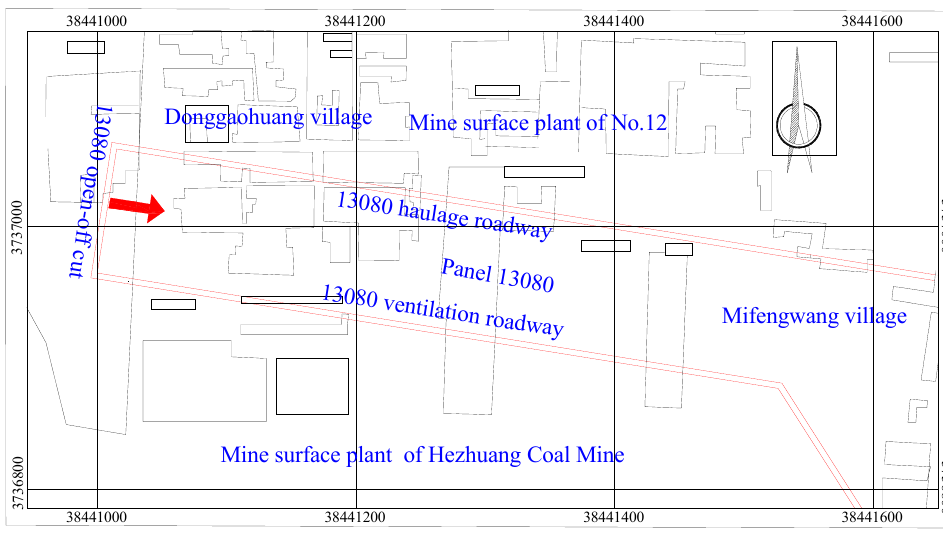
Figure 15. The surface-underground contrast layout of panel 13080.